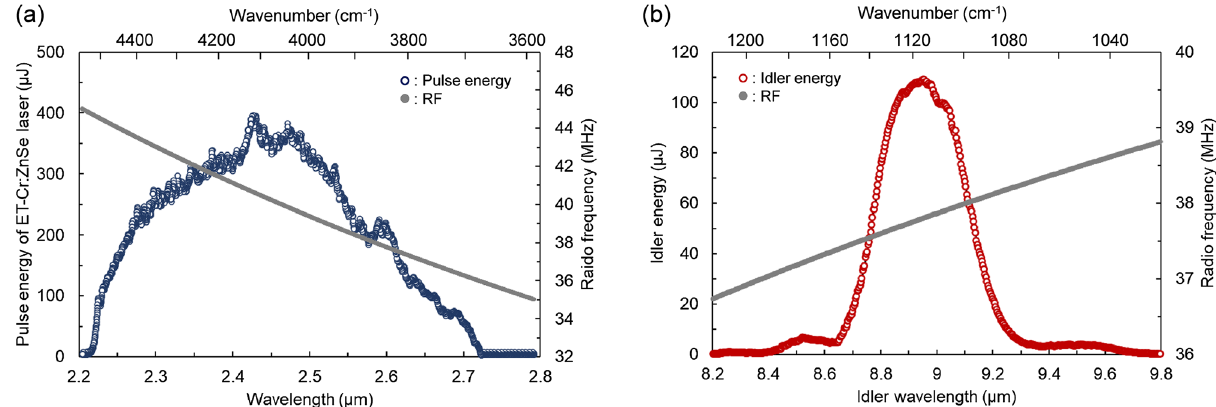
Figure 3. ( a ) Electronic tuning range of the ET-Cr:ZnSe laser and filter tuning curve of the AOTF. ( b ) Electronic tuning range of idler when PM angle was fixed at 50.6°. Gray plots correspond to RFs fed into the AOTF for electronic wavelength